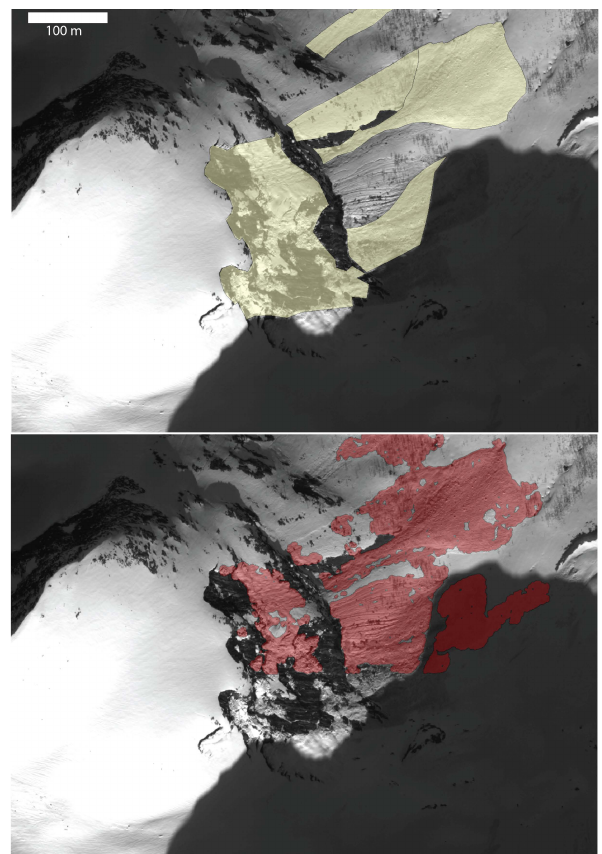
Fig. 9. Identification of snow avalanches in the Dalsfjord region through manual digitising ( a , above) and automated digitising ( b , below) methods.